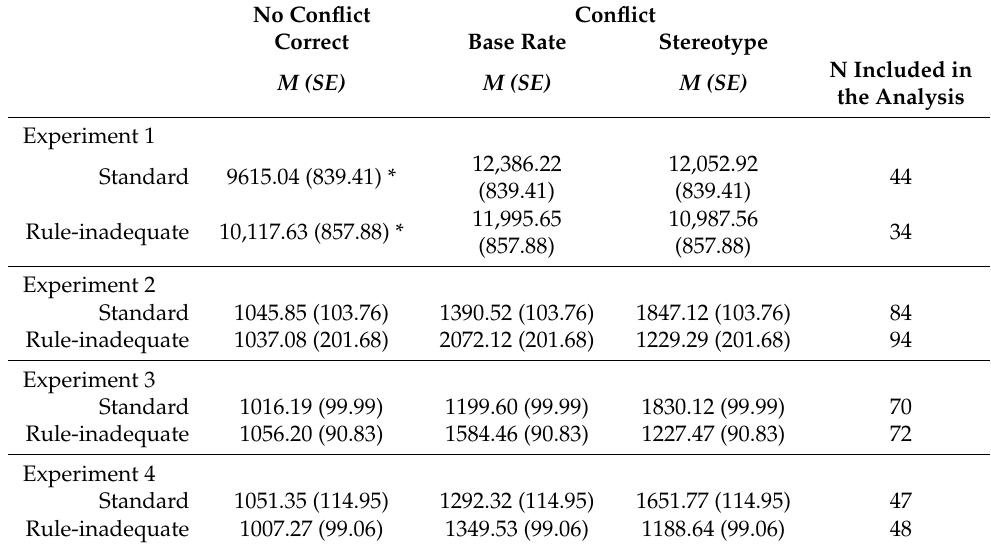
Table A2. Response times (in ms) for each kind of response in each type of problem across experiments.